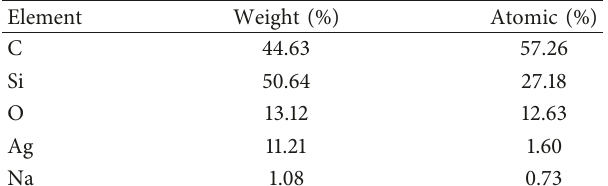
Figure 3: The submerged arc discharge method (SADM) system. (a) SADM system configuration. (b) Ionization and plasma for- mation. (c) Metal bursts out. (d) Metal particle suspended or precipitated in the dielectric liquid. Table 1: EDX application for the analysis of the proportion of elements in silver.